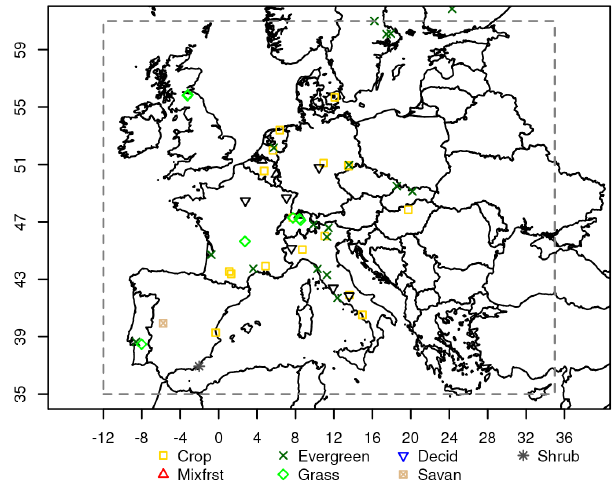
Figure 1. Eddy covariance sites used in the study. The dashed line delimits the exact domain used to calculate the aggregated